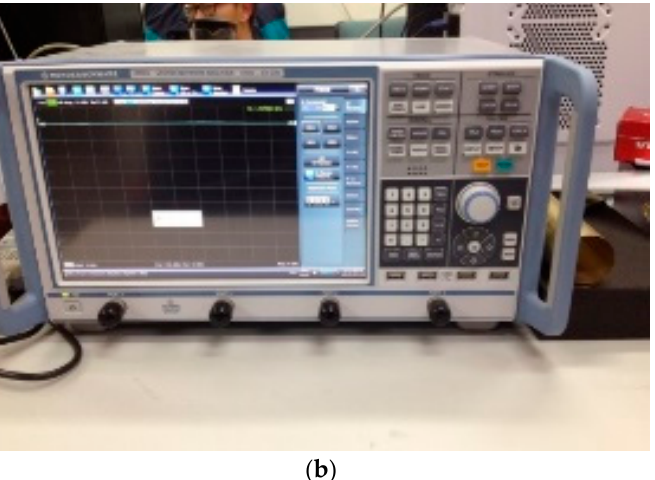
Figure 7. Experimental apparatus. ( a ) Schematic of experimental system, ( b ) Vector network analyzer.